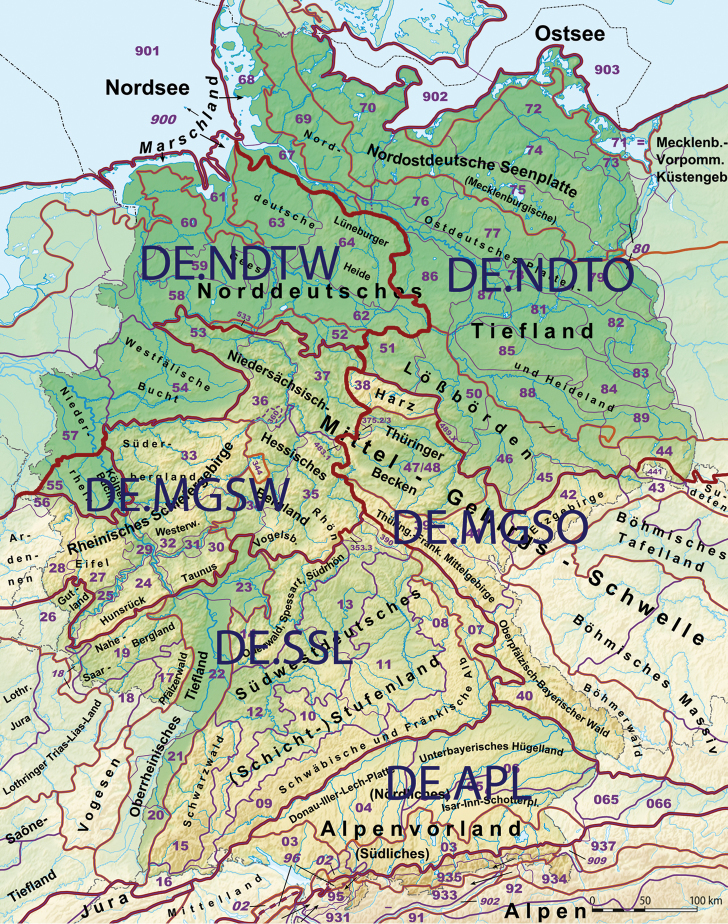
Modified biogeographic regions of Germany, based on Naturräumliche Großregionen of Germany, Meynen and Schmithüsen (1953–1962) and http://commons.wikimedia.org/wiki/File:Deutschland_Naturraeumliche_Grossregionen.png